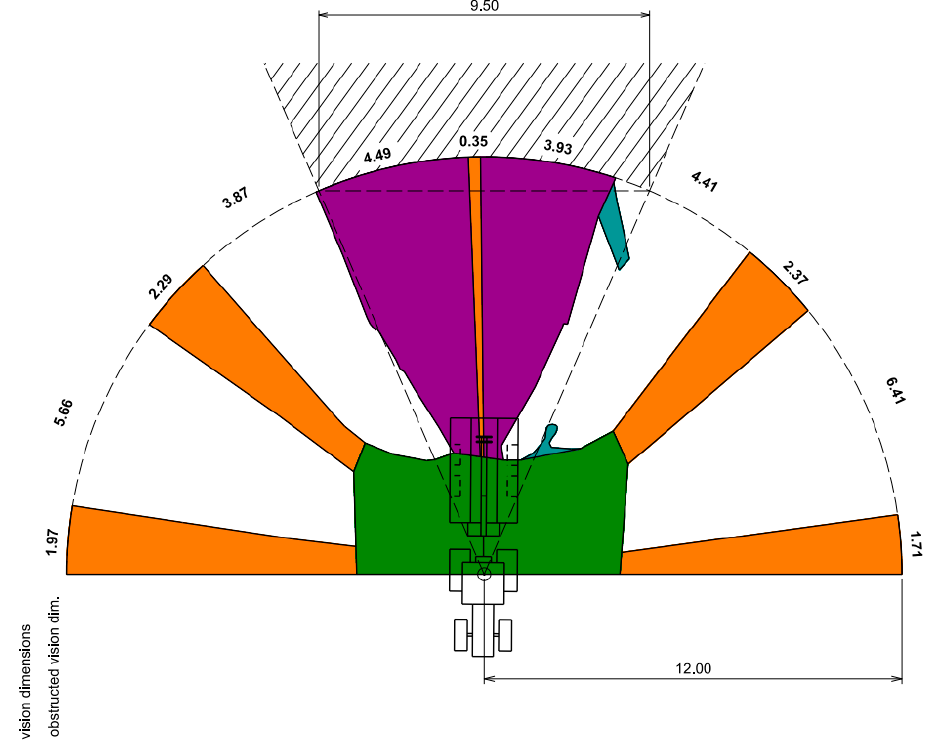
Figure 4. Graphical evaluation of the semicircular field of rear view from the cabin of tractor Valtra T 6300 with the coupled trailer in the position with identical axes.